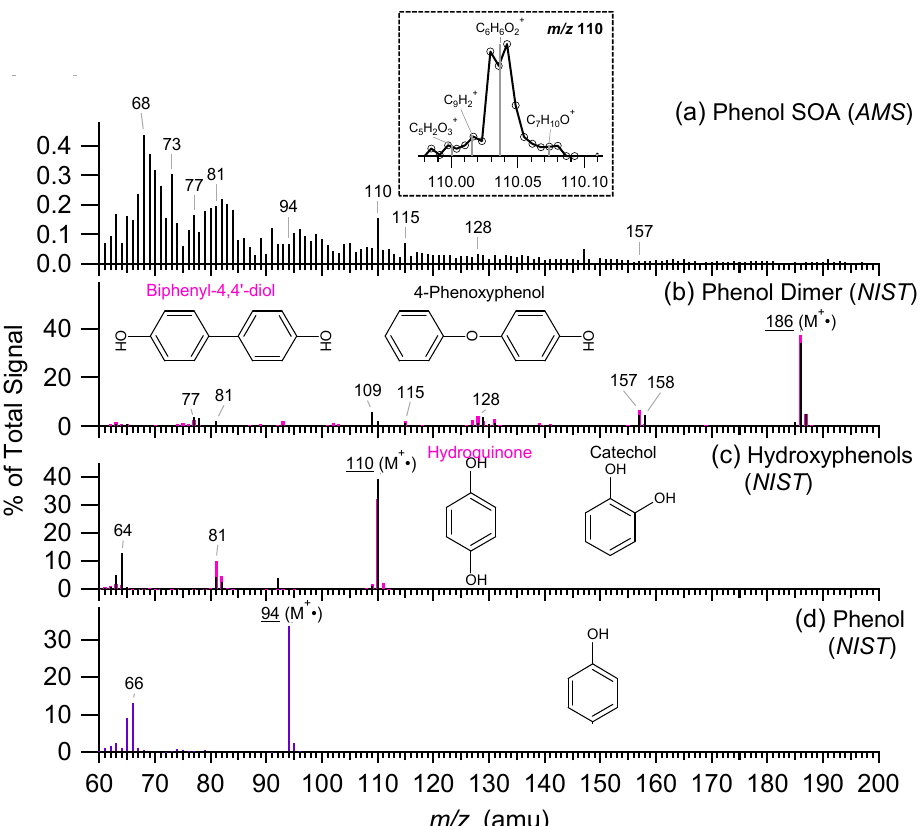
Fig. 8. Comparisons of (a) the AMS spectrum of phenol SOA produced via aqueous phase photoreactions (w/OH, pH=5) with the NIST mass spectra of (b) the C-C coupled (biphenyl-4,4’-diol) and C-O coupled (4-phenoxyphenol) dimers of phenol, (c) hydroquinone and catechol, and (d) phenol. The molecular ions (M + ) are marked and the molecular structures are shown. The inset in (a) shows the high resolution spectrum of phenol SOA at m/z 110, which is primarily C 6 H 6 O + – the molecular ions of 2